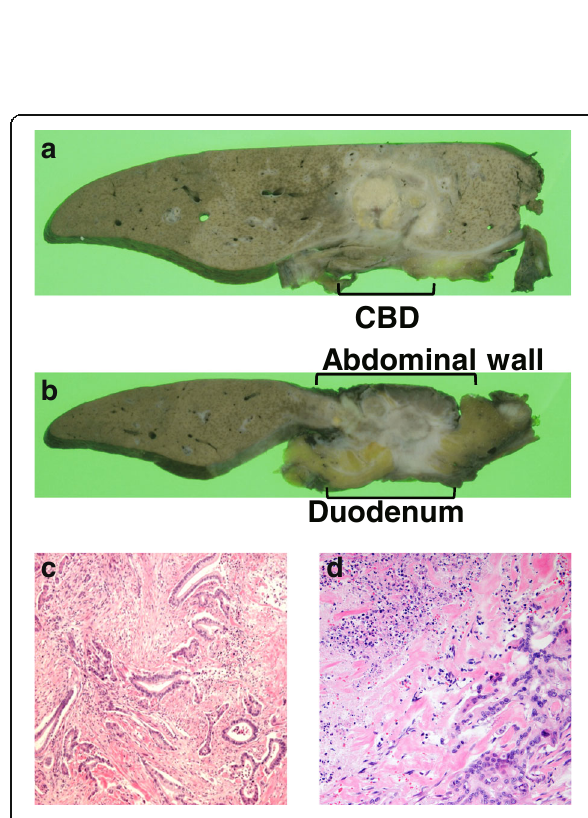
Fig. 5 Pathological findings. a , b Macroscopically, the mass invaded the common bile duct, duodenum, transverse colon, and abdominal wall. c Histological examination revealed moderately differentiated adenocarcinoma (residual adenocarcinoma). d Histologically, necrosis or degeneration tissue ( top left corner of the figure) was found in one half to two thirds of the whole area, indicating a grade 1b